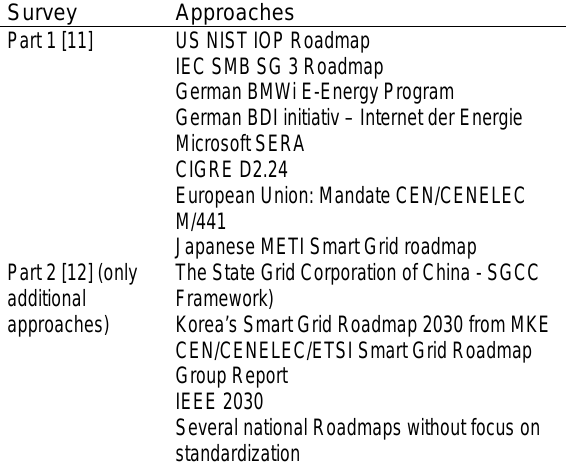
Table 1. Overview on addressed approaches within the